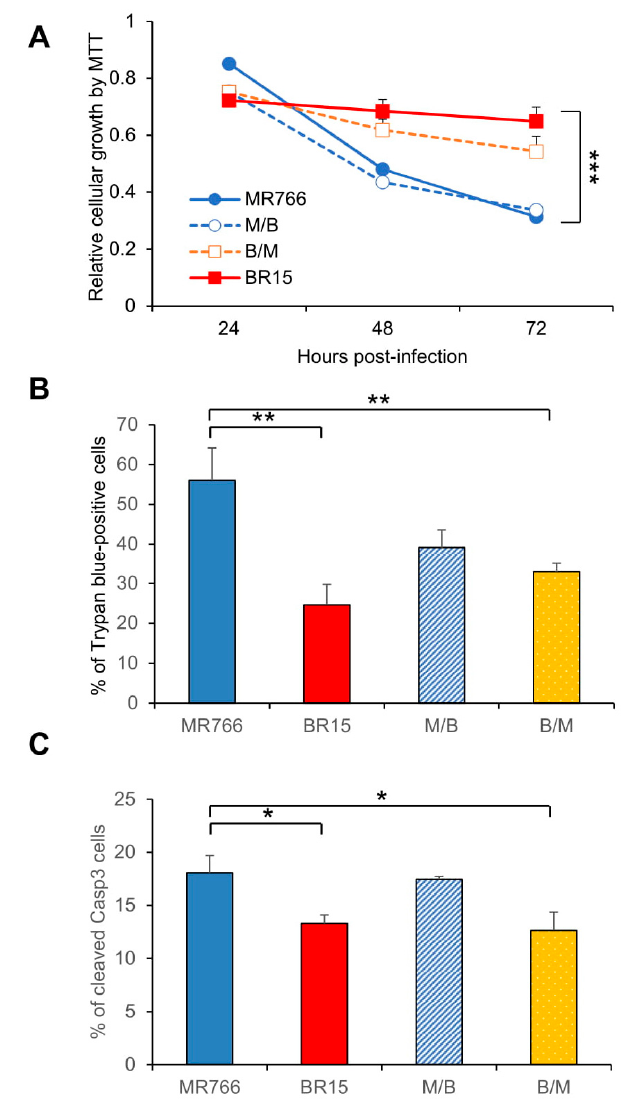
Figure 4. Correlation of the C-prM with ZIKV-induced growth restriction and apoptotic cell death. ( A ) Cell proliferation was measured by the MTT assay. Statistic t-test shows the differences shown among three viruses are not significant. ( B ) ZIKV-induced cell death was measured by the Trypan blue assay 72 h p.i. Two different experiments were carried out. Average number of cells counted was about 100-200. Differences between MR766 vs. BR15, and MR766 vs. B/M were both high significant with p ≤ 0.05 (**) for both comparisons. The difference between MR766 and M/B was not significant with p = 0.11. ( C ) ZIKV-induced apoptosis was measured by cleavage of caspase-3. Cells were collected at 72 h p.i. All results represent average and standard deviation (X ± SD). Levels of statistical significance were calculated by Two-way ANOVA for ( A ). The difference between MR766 and BR15 is highly significant with p < 0.01